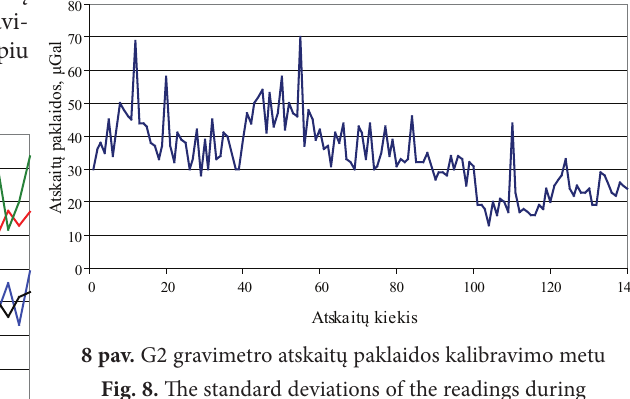
Fig. 8. The standard deviations of the readings during calibration of the gravimeter g2